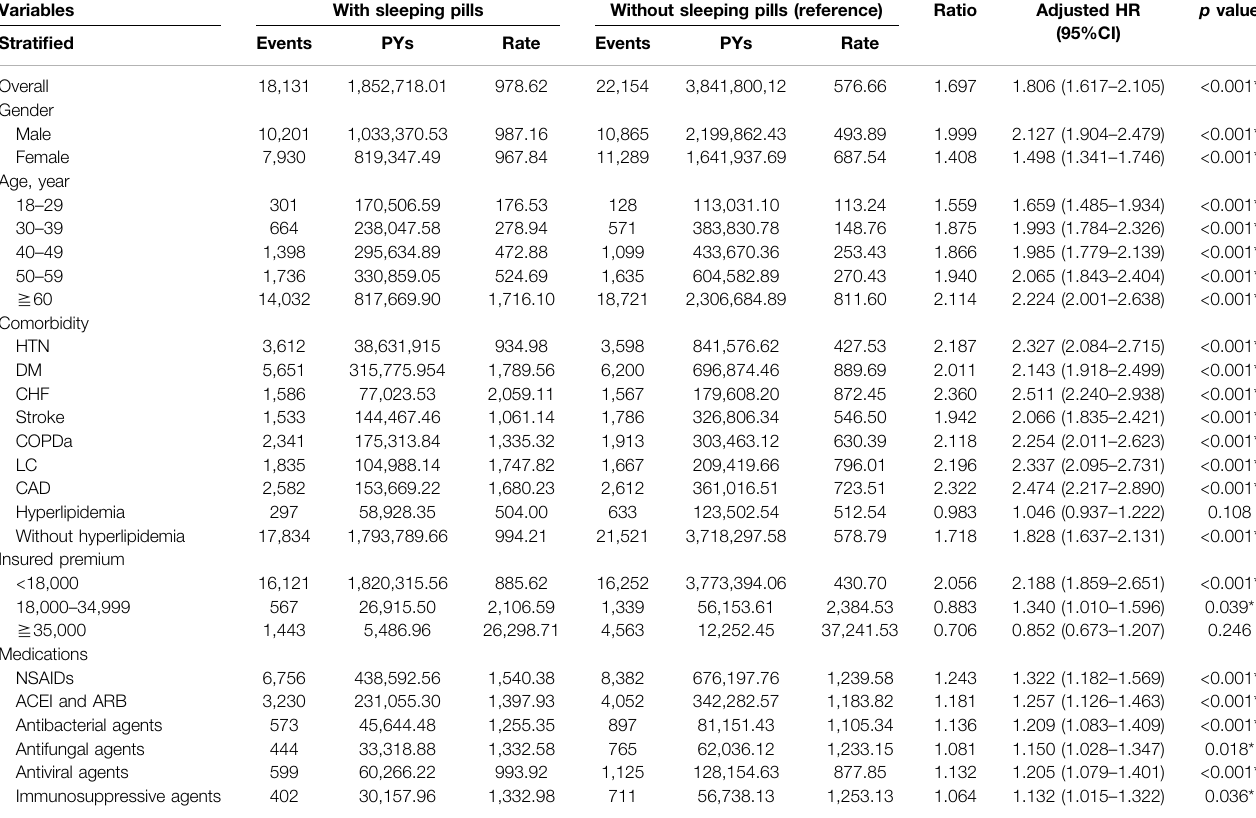
TABLE 1 | Factors of CKD at the end of the follow-up period strati fi ed by Cox regression.